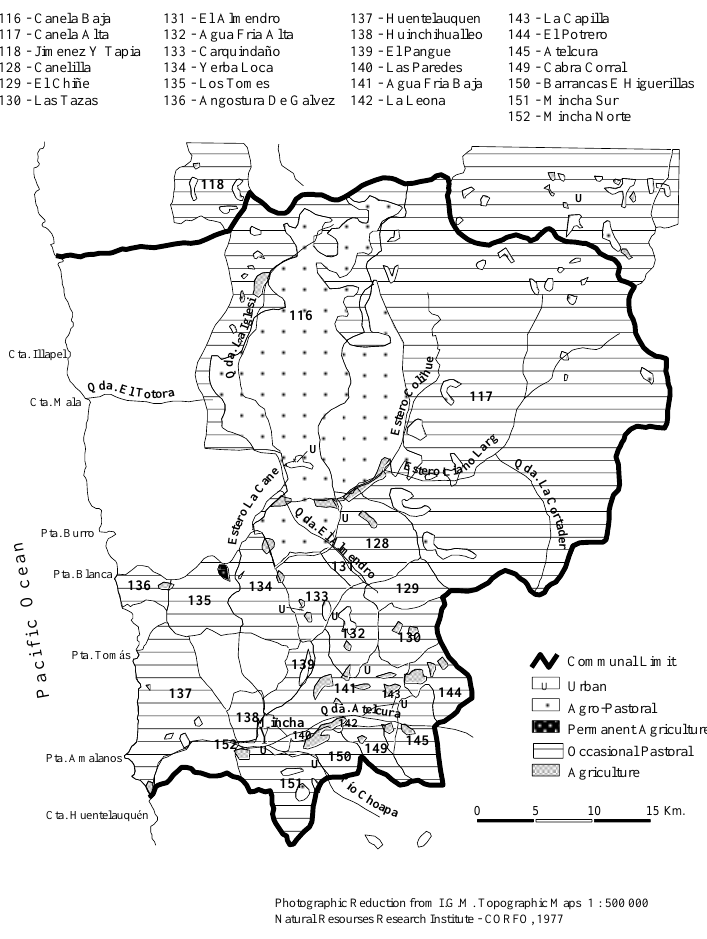
Figure 2. Agricultural communities in the Canela Commune. Number 137 corresponds to the Huentelauquén Agricultural Community (HAC).